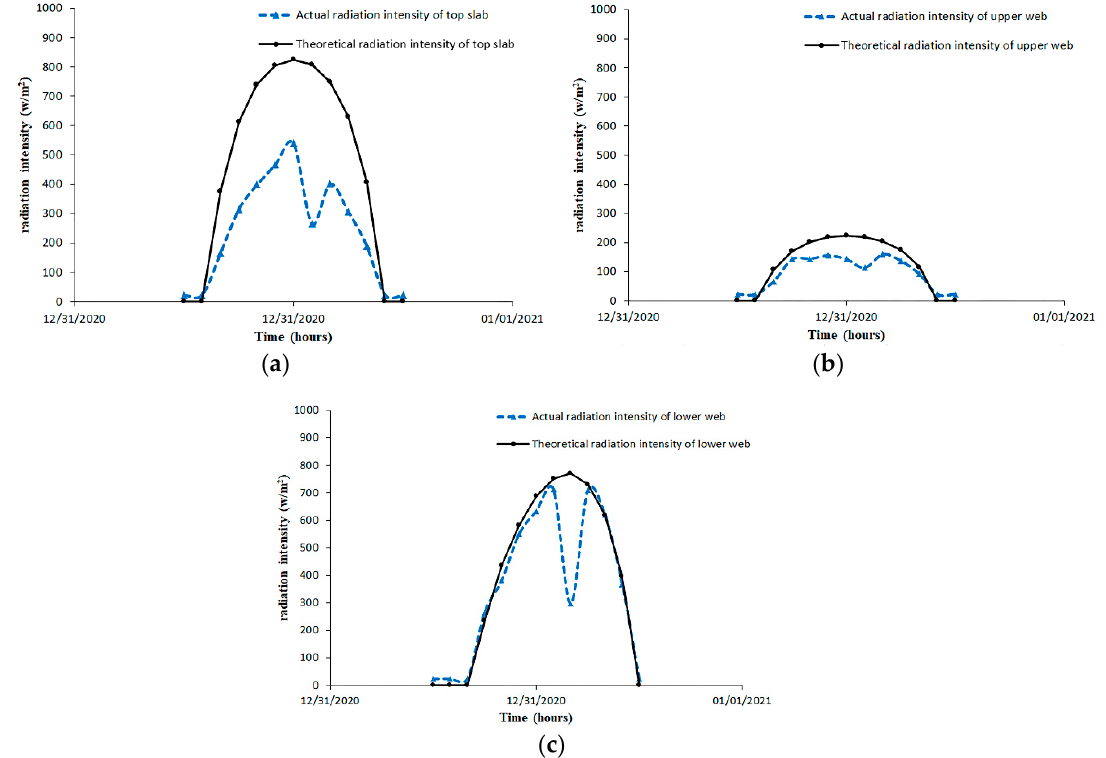
Figure 5. Comparison between measured and theoretical solar radiation intensities. ( a ) Solar radiation on the top slab; ( b ) solar radiation on the upper web; ( c ) solar radiation on the lower web.